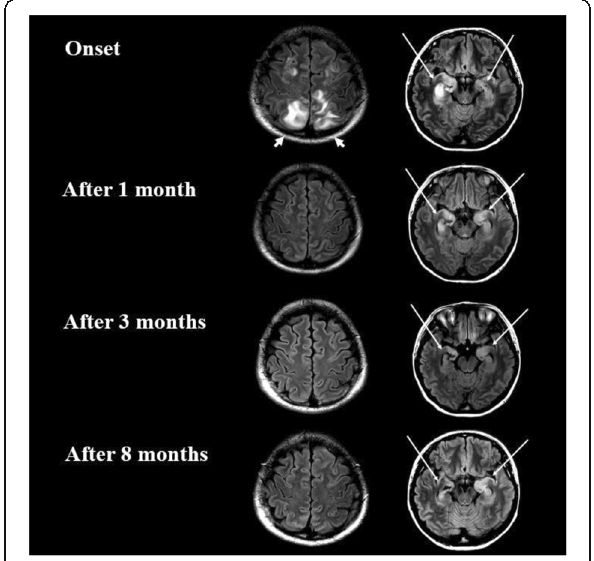
Fig. 1 (abstract P33). Brain MR findings show PRES (short arrows) and persistent high signal change in bilateral hippocampi and progressive atrophy in the right medial temporal structures (long